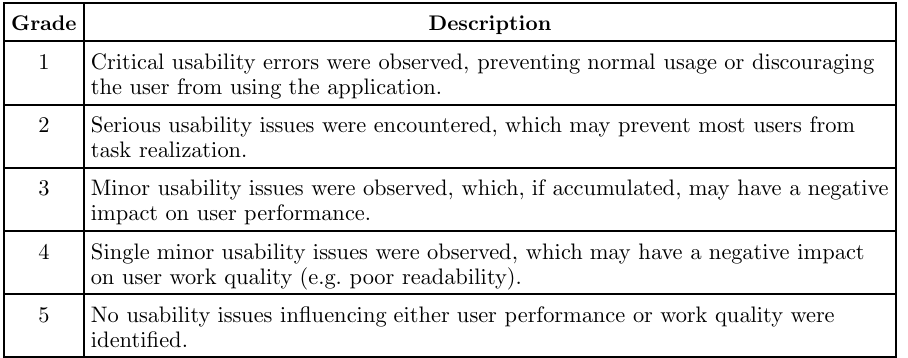
Table 2. The grading scale Grade